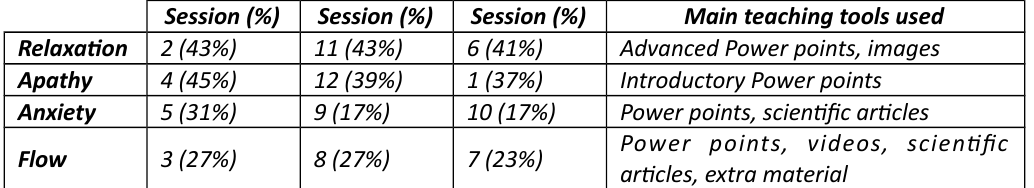
Table 1. Sessions with the major indexes of relaxaton, apathy, anxiety and